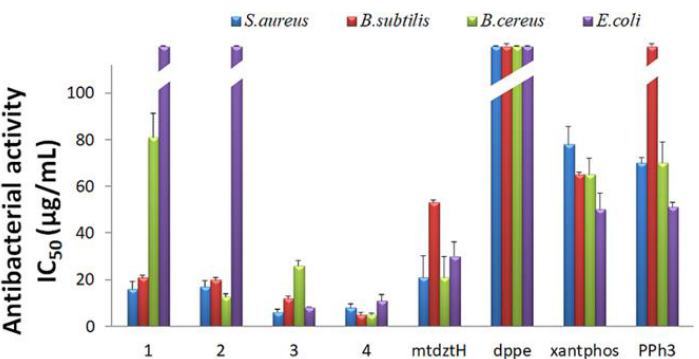
Figure 3. In vitro antibacterial activity of compounds 1 – 4 , and their ligands mtdztH, dppe, xantphos, and PPh 3 in free form, expressed as half-minimum inhibitory concentration (IC 50 ) values (in µ g/mL) provided by a nonlinear curve fit-growth/sigmoidal-dose response on the experimental optical density data. Values are expressed as mean ± standard deviation (SD) of three replicate measurements (with the exception of values higher than 100 μg/mL).